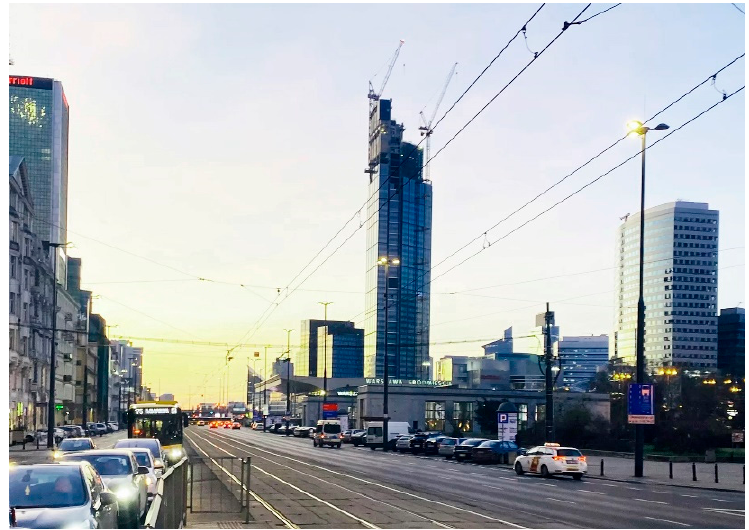
Figure 2. Lim Tower (to the left), Varso Tower (center), Skylight Tower (to the right). Source: author’s study.